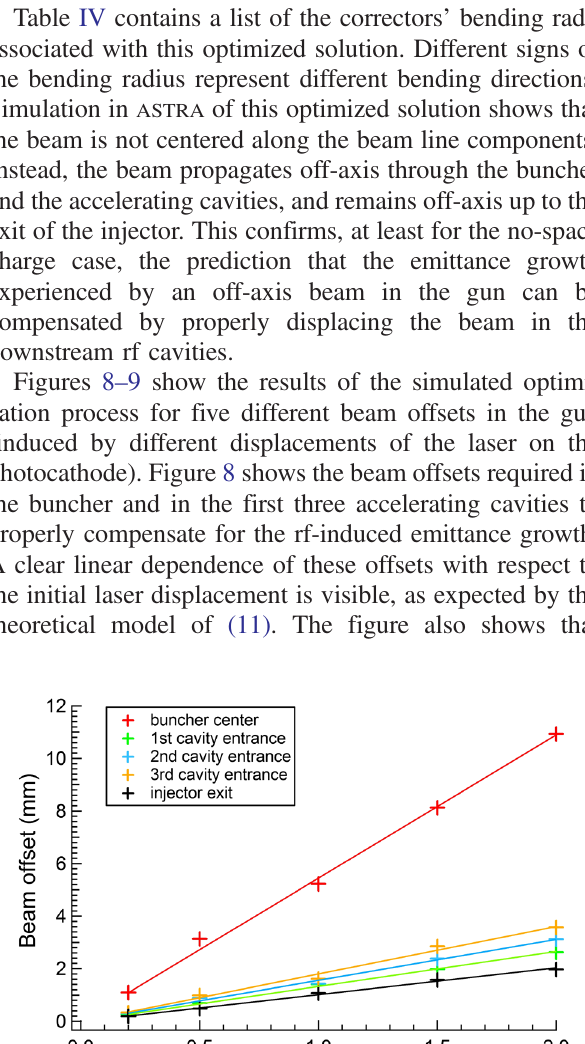
FIG. 9. Simulation results showing the residual emittance growth (after the compensation technique is applied) as a function of the initial laser offset at the cathode. Wakefield effects not included.